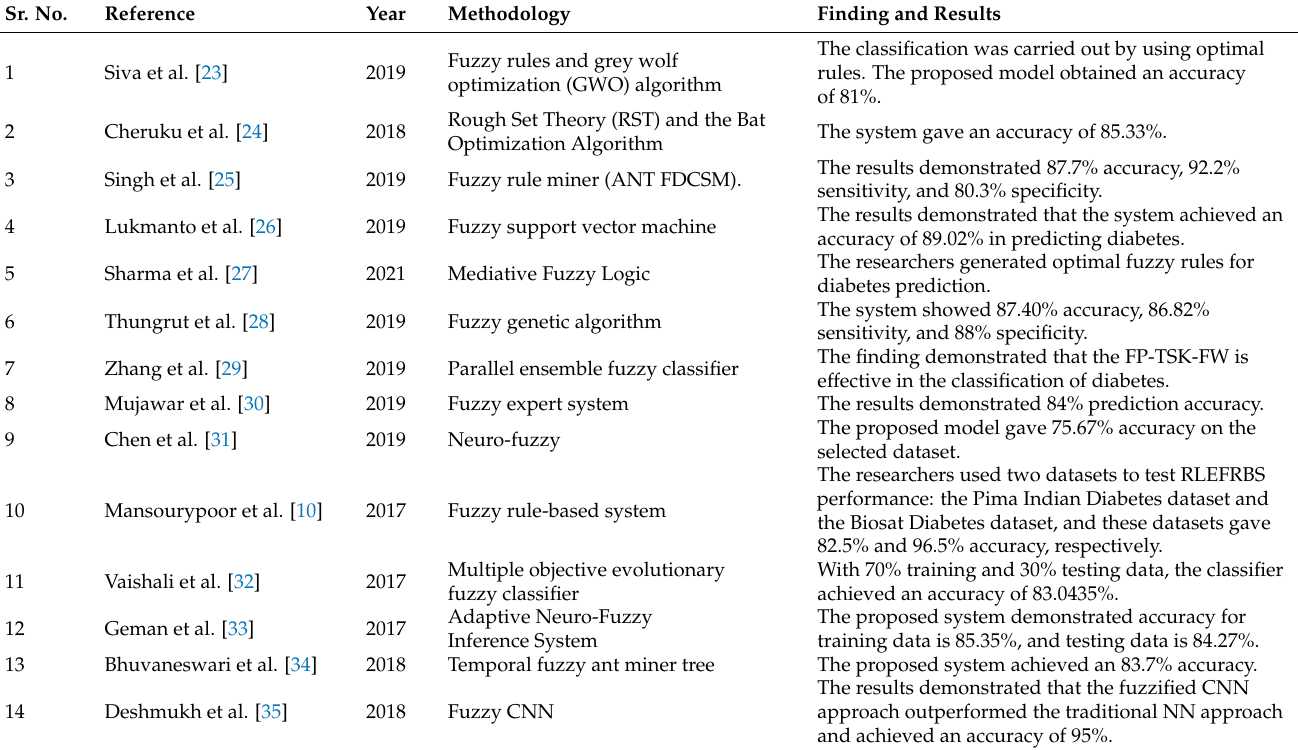
Table 2. Summary of fuzzy logic techniques for diabetes